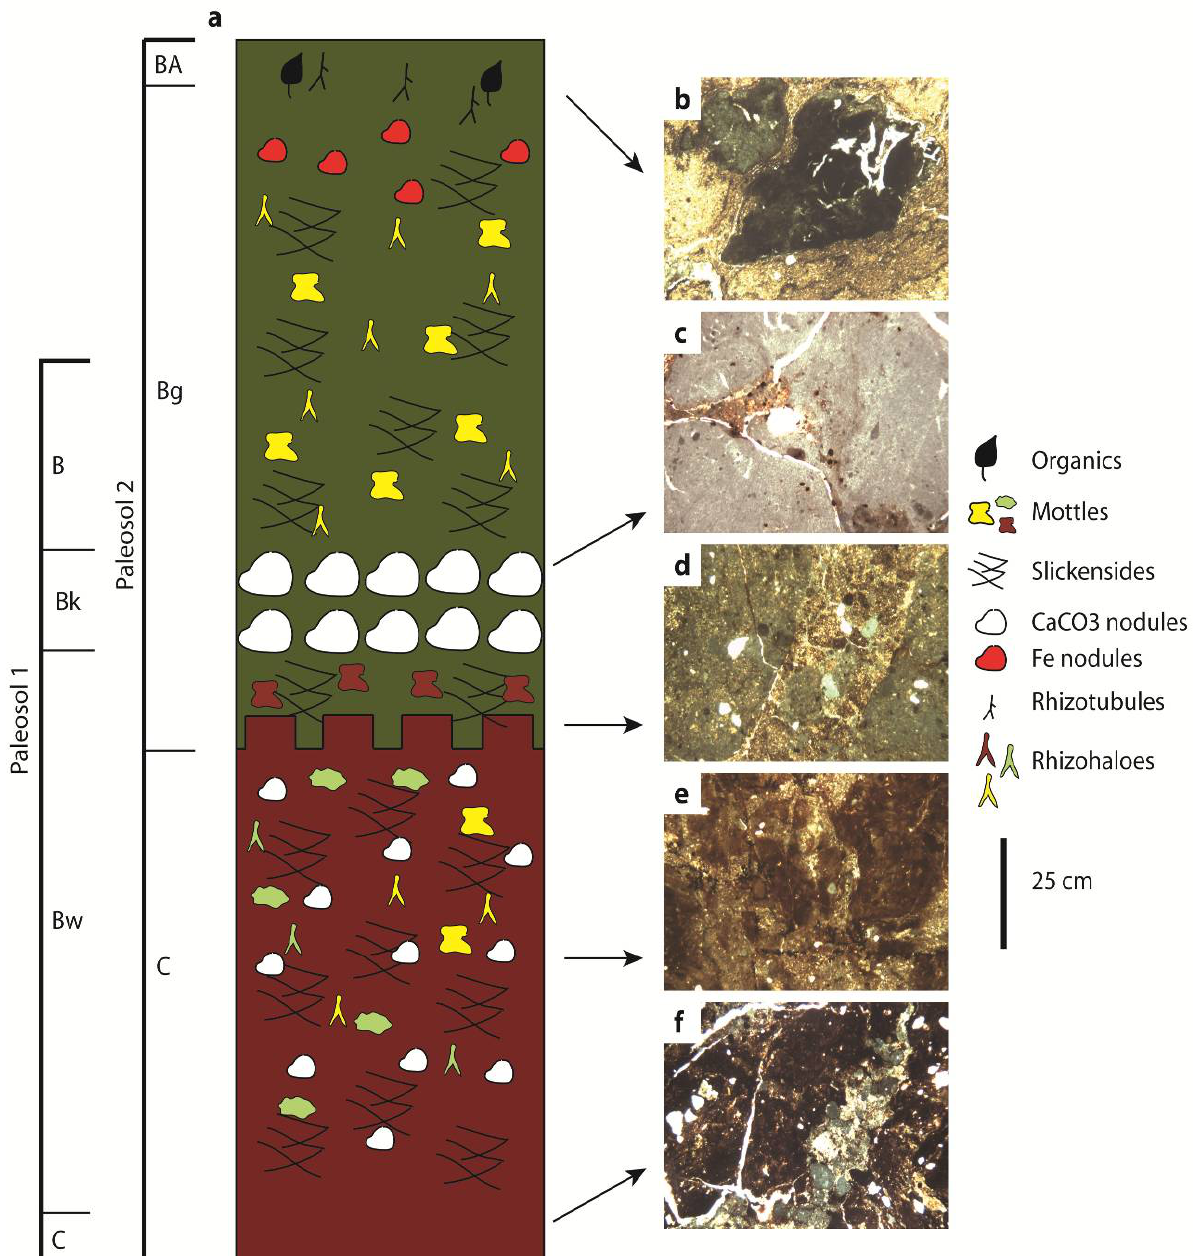
Figure 4. Detailed stratigraphic column and micromorphological features of the interpreted paleosols present in Section 2. ( a ) Detailed section of Units 1 and 2; ( b ) Carbonate nodule with secondary sparry calcite, 0–20 cm; ( c ) Coalescing carbonate nodules within the Bk horizon, 120–140 cm; ( d ) Root trace and porphyroskelic fabric, 140–160 cm; ( e ) Clay aggregates showing the insepic microfabric, 180–200 cm; ( f ) Carbonate nodules, 260–280